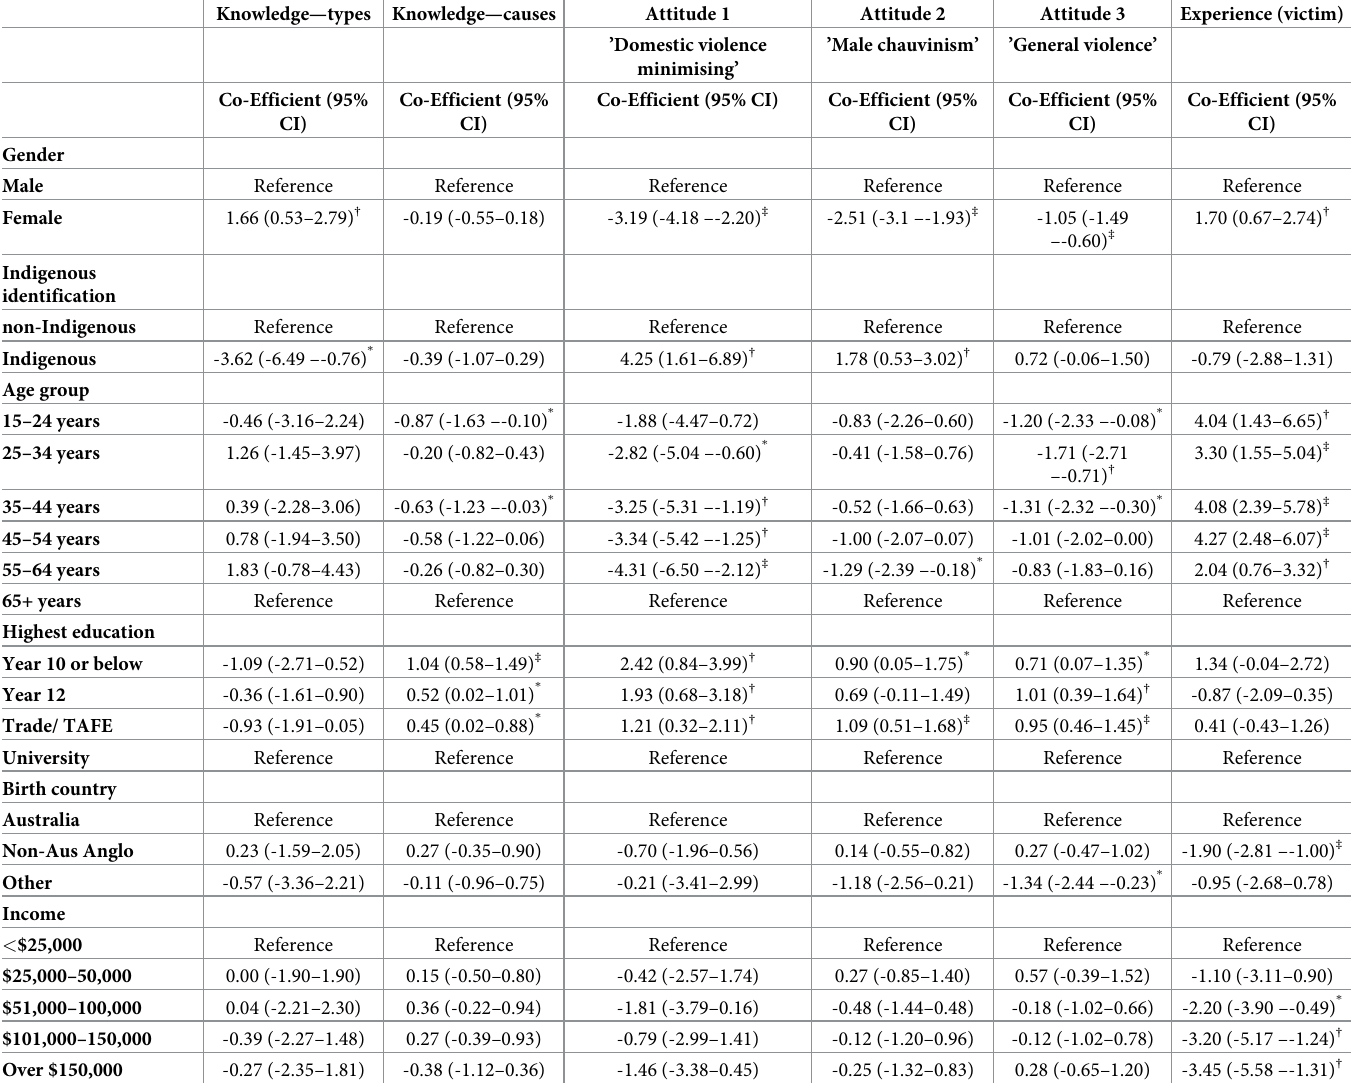
Table 3. Independent socio-demographic predictors of responses to composite